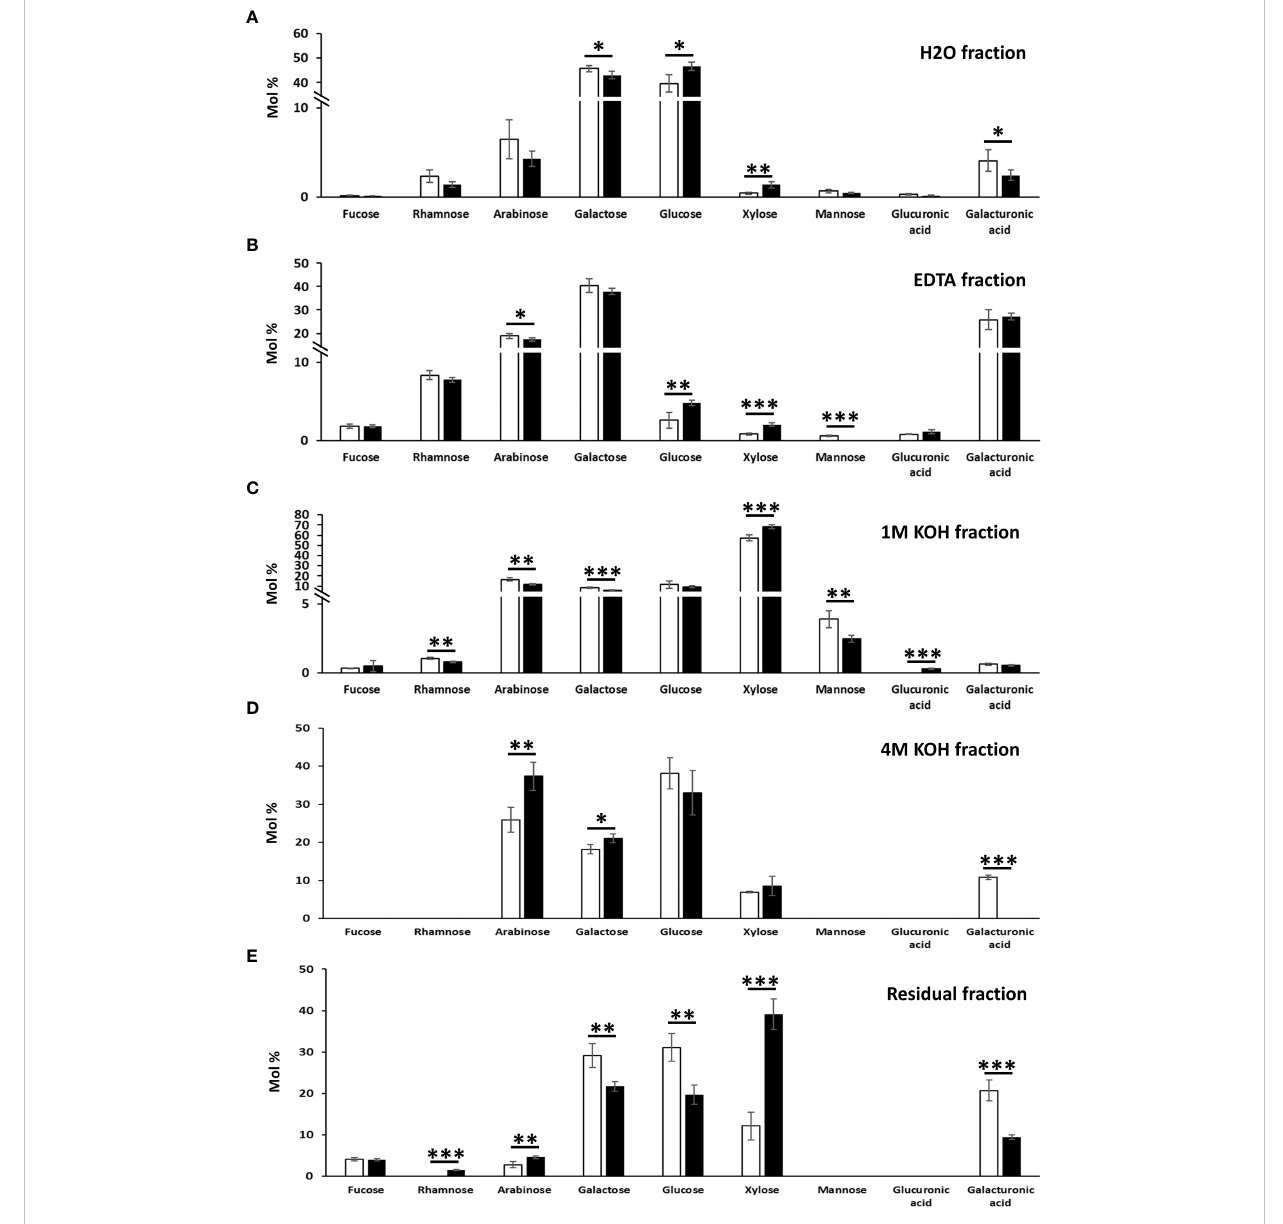
FIGURE 4 Monosaccharide composition of the cell wall fractions obtained by sequential extractions with hot water (A) , EDTA (B) , 1 M KOH (C) , 4 M KOH (D) and of the remaining residue (E) in N. benthamiana leaves agroin fi ltrated with the empty vector and MdMYB68 constructs. Samples were collected 7 days after in fi ltration. Values are expressed as the mean ± SD from four biological replicates. One, two and three asterisks indicate signi fi cant differences at p < 0.05, p < 0.01, p < 0.001,